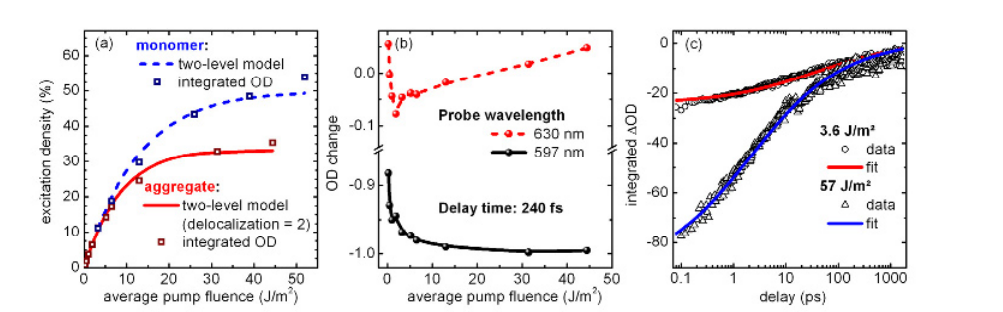
Fig. 2. (a) Excitation density in monomer units for PBI1 aggregates (solid line) and PBI1 monomers (dotted line, in dichloromethane). (b) Transient absorption of PBI1 aggregates in dependence of the pump fluence for two different wavelengths. (c) Time evolution of the integrated transient spectra for a low (3.6 J/m², circles) and a high (57 J/m², triangles) pump fluence. The solid lines are fits of a diffusion driven annihilation